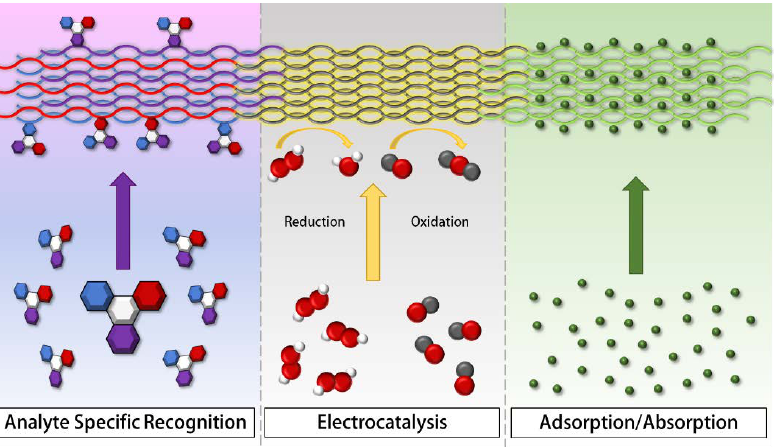
Figure 1. Diagram representing the primary sensing mechanisms for nanofiber-based sensors. Left: analyte specific recognition (ASR)—specificity is represented by the colors of the fiber matching the color of the functional group on the analyte it binds to. Center: electrocatalysis (EC)—reduction or oxidation is catalyzed by enhanced electron movement through nanofibers. Right: adsorption (AD)—molecules are trapped on nanofiber surfaces due to high porosity and large specific surface area.